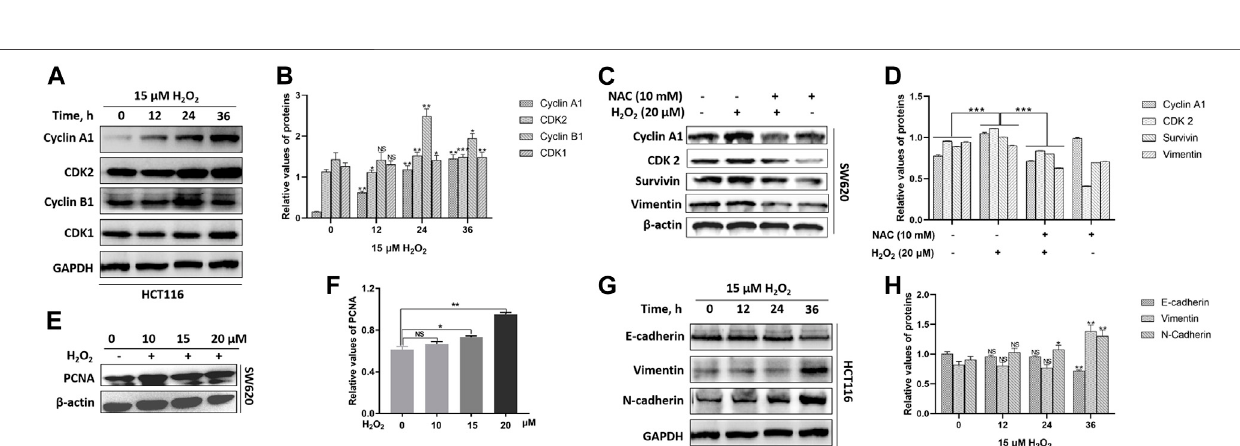
FIGURE3| H 2 O 2 regulatedtheexpressionlevelsofcellcycle-relatedandEMT-relatedproteins. (A) TheHCT116cellsweretreatedwithorwithout15 μ MH 2 O 2 for differenttime.TheexpressionlevelsofCyclinA1,CDK2,CyclinB1,CDK1weremeasuredbywesternblot. (B) Quantitativeresultsofcellcycle-relatedproteinexpression levels. (C) The SW620 cells treated with or without 20 μ M H 2 O 2 or pretreated with 10 mM NAC. The expression levels of Cyclin A1, CDK2, surviving and vimentin were measured by western blot, which could be down-regulated by the antioxidant NAC. (D) Quantitative results of protein expression. (E) The expression of PCNA in SW620 cells treated with different concentration of H 2 O 2 was measured by western blot. (F) Quantitative results of PCNA expression levels. (G) The HCT116 cells treated with or without 15 uM H 2 O 2 for different time. The expression levels of E-cadherin, vimentin and N-cadherin were measured by western blot. (H) Quantitative results of EMT-related protein expression levels. All experiments were repeated three times or more. Error bars represent ± S.D. p < 0.05 was considered to be statistically signi fi cant. * p < 0.05; ** p < 0.01, *** p < 0.001.